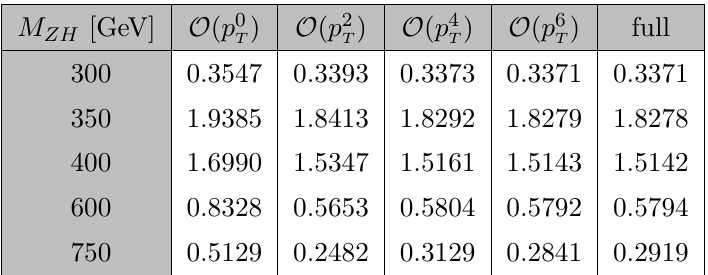
and the full computation for several T